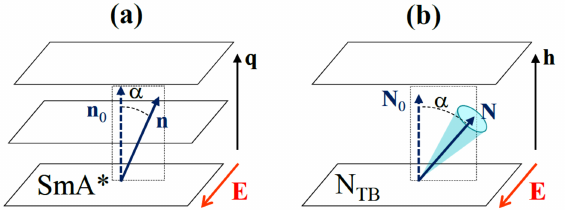
Figure 3. Electroclinic effect in the SmA* ( a ) and N TB ( b ) phases. When the field is applied in the plane of the SmA* layers, the director n rotates in a plane perpendicular to E and tilts at an angle α with respect to the normal layers. Similarly, when an electric field is applied in a direction parallel to the N TB pseudo-layers, the optic axis, N , tilts away at an angle α from the helix axis, h , in a plane perpendicular to E . The whole director cone (the shaded region) tilts by the same angle α , without much